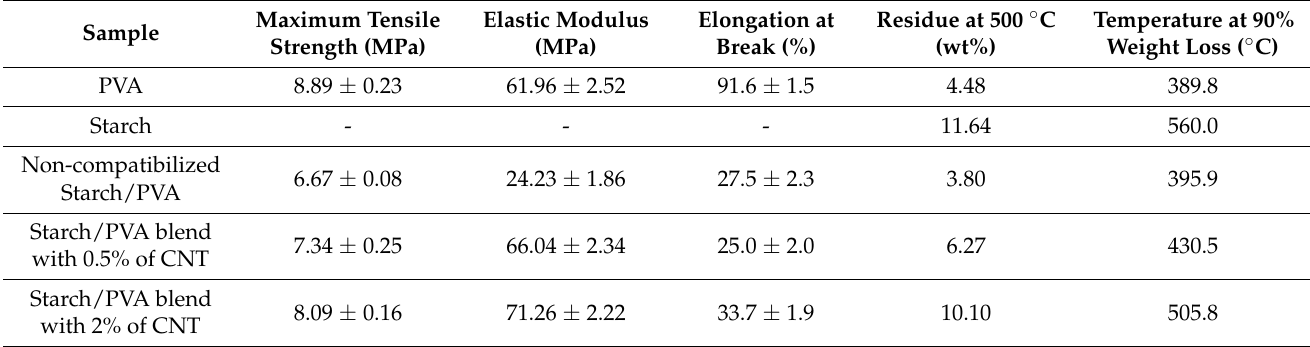
Table 4. The summary of thermal and mechanical properties of the Starch/PVA blends compatibilized with CNT [56].